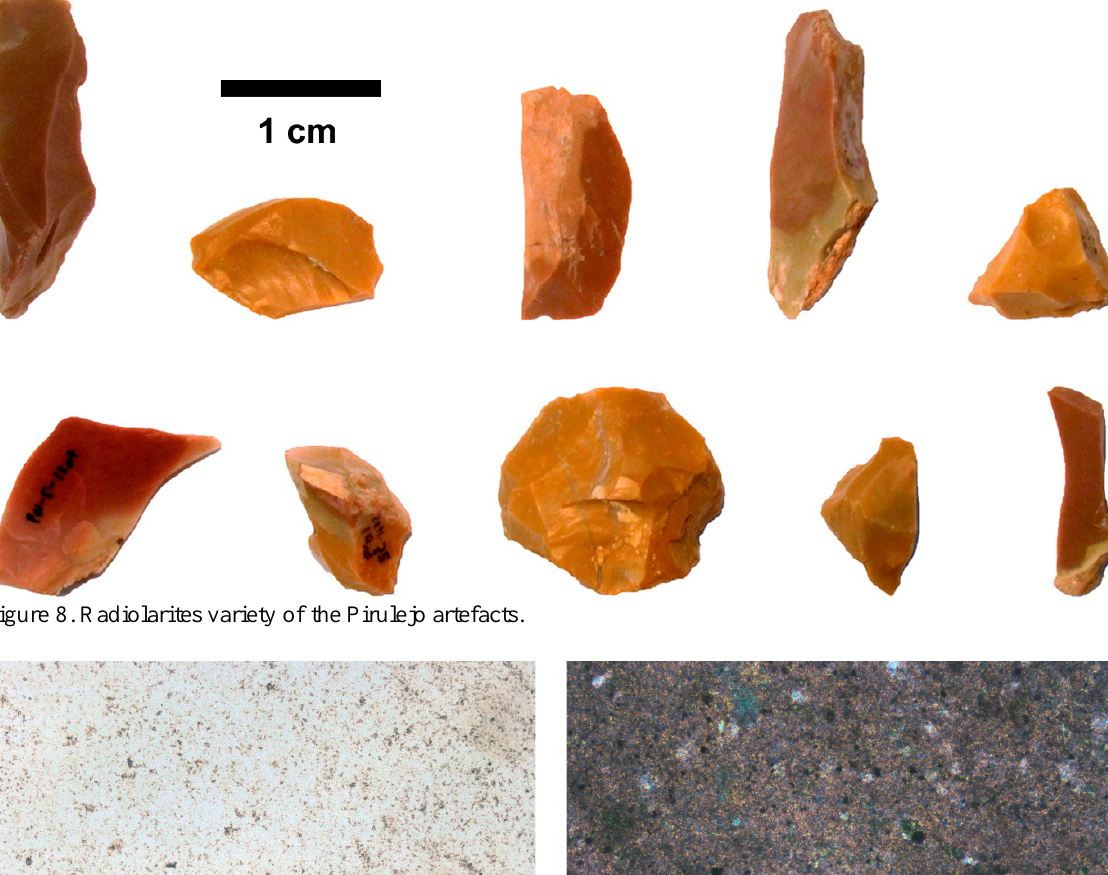
Figure 9. View of the petrographic analysis of siliceous variety radiolarites. (Parallel polarisers, left, X4. Crossed polarisers, right.) Scale bars are 500 μm wide.